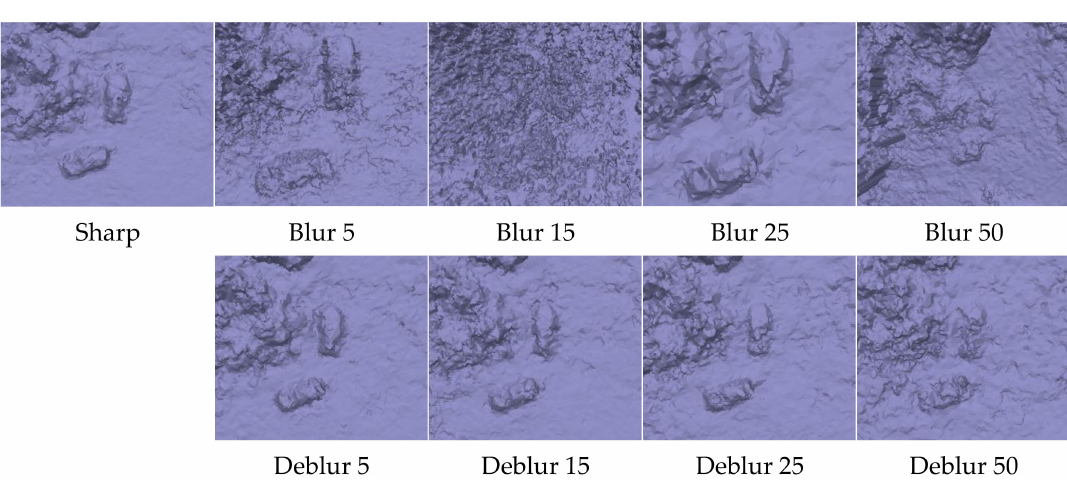
Figure 9. Solid model—visual comparison of the product part developed using photos with a varying blur kernel and their corresponding product, after the application of the